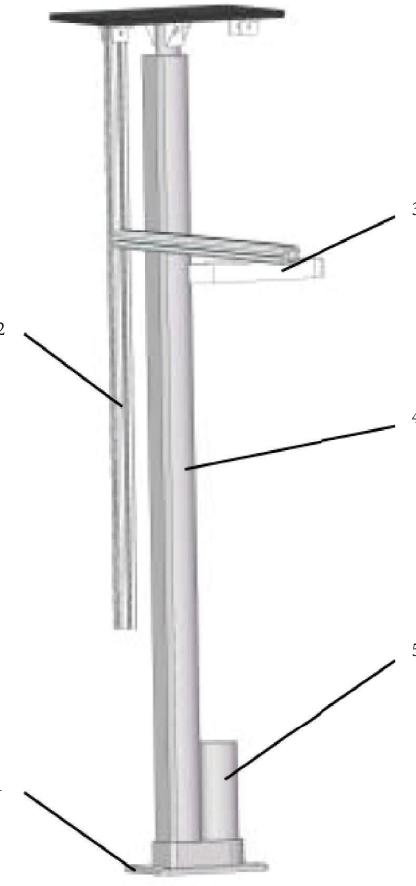
Figure 4: Electronic control lift image acquisition bracket. (1) Connecting seat. (2) Cantilever bracket. (3) Camera module. (4) Telescopic rod. (5) Linear